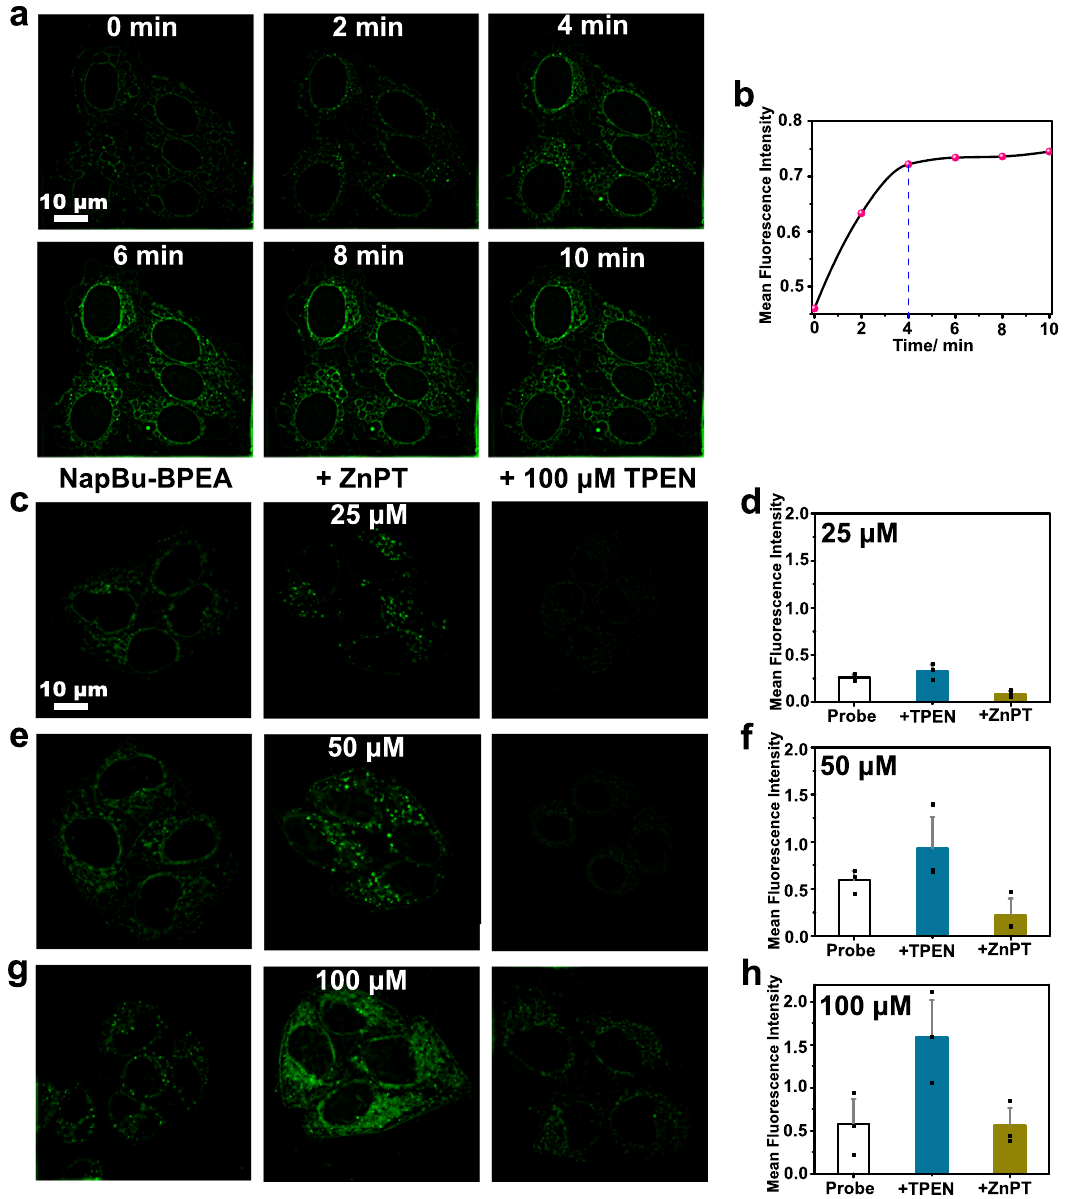
Fig. 4 NapBu-BPEA can sense intracellular labile Zn 2 + in a reversible manner. a SIM imaging of the NapBu-BPEA-stained HeLa cells (10 μ M, 1 h, 37 °C) upon incubation with 50 μ M ZnPT; and b the corresponding temporal pro fi le of intracellular fl uorescence increase. c – h SIM imaging of the probe-stained (10 μ M, 1 h, 37 °C) HeLa cells undergoing ZnPT (25 μ M, c , d ; 50 μ M, e , f ; 100 μ M, g , h ) incubation (10 min) and subsequent TPEN (100 μ M, 30 min) treatment; and the corresponding histograms ( d , f , h ) of the determined average fl uorescence intensity in cells from n = 3 biologically